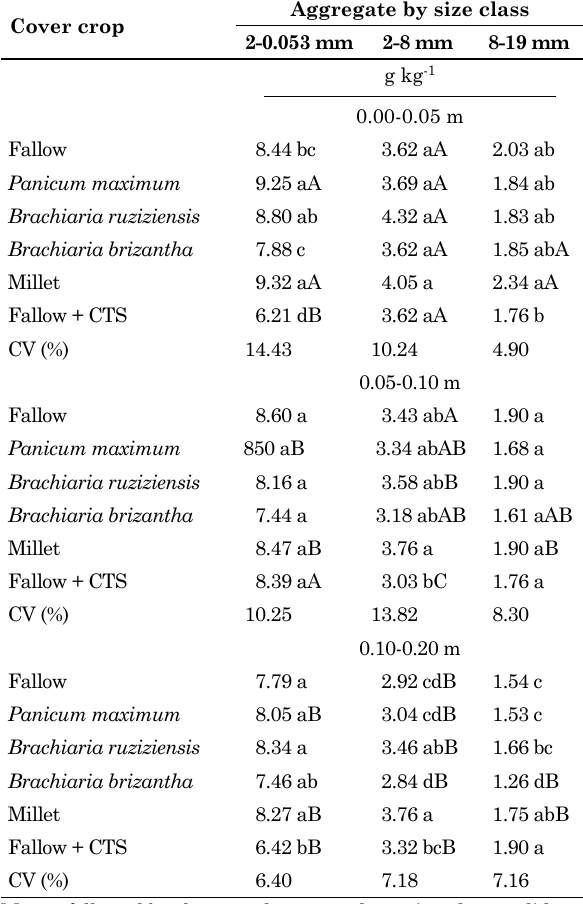
table 3. concentration of total organic carbon in the fraction of soil aggregates as affected by cover crops in rotation with rice under a no-till system at each soil depth (0.00-0.05, 0.05-0.10, and 0.10-0.20 m)